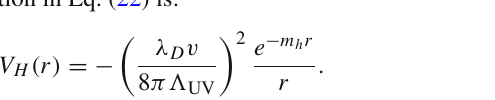
Table 2 Freeze-out mass predictions for millicharged WIMP DM. The annihilationcross-sectionincludesboththecontributionofSEandBSF. For the triplets, a second prediction, denoted with a *, for the thermal mass is present due to the emergence of a large resonance in the Som- merfeld enhancement for M DM ≈ 2 . 4 TeV. We provide a measure of DM spin n (cid:18) M DM (TeV) (cid:4) Landau / M DM (σv) J = 0 tot /(σv) J = 0 max Complex scalar 3 1 . 60 ± 0 . 01 − 2 . 4 ∗